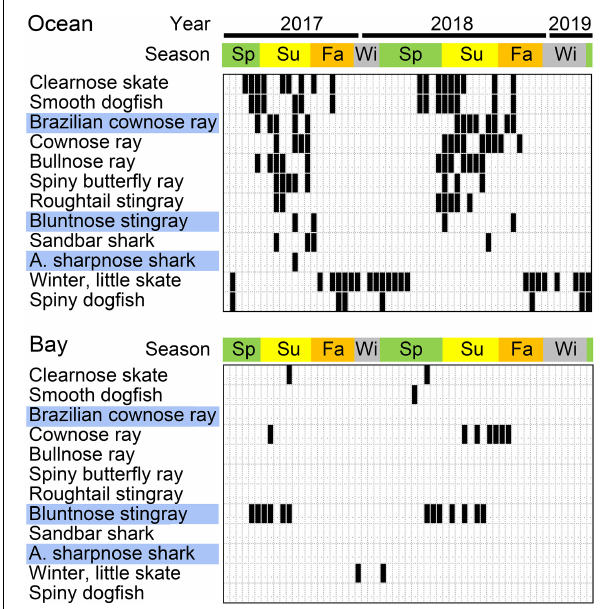
FIGURE 6 | Sharks, rays, and skates found by eDNA metabarcoding in coastal New Jersey. Positive samples are indicated in black. Fishes with new reference sequences reported in this study are highlighted in